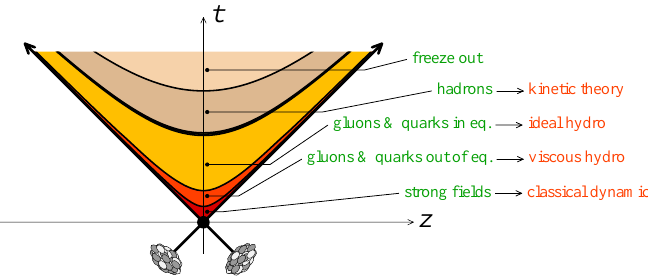
Figure 1. The stages of a heavy ion collision (from